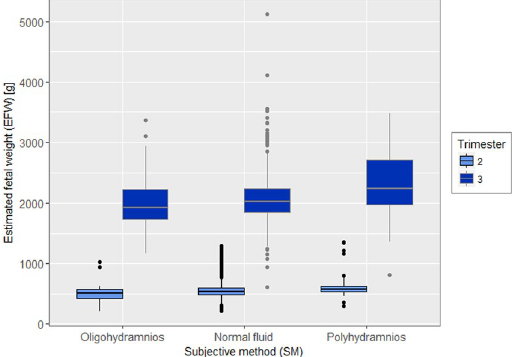
Figure 2. Distribution of Estimated Fetal Weight (presented in box plot) stratified by 2nd (18–28 weeks) and 3rd (29–40 weeks) trimester of pregnancy in each category of amniotic fluid according to Subjective Method (SM) evaluation.